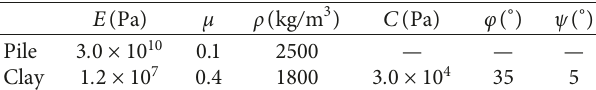
Figure 3: Schematic of the model. Table 2: Soil and pile properties for